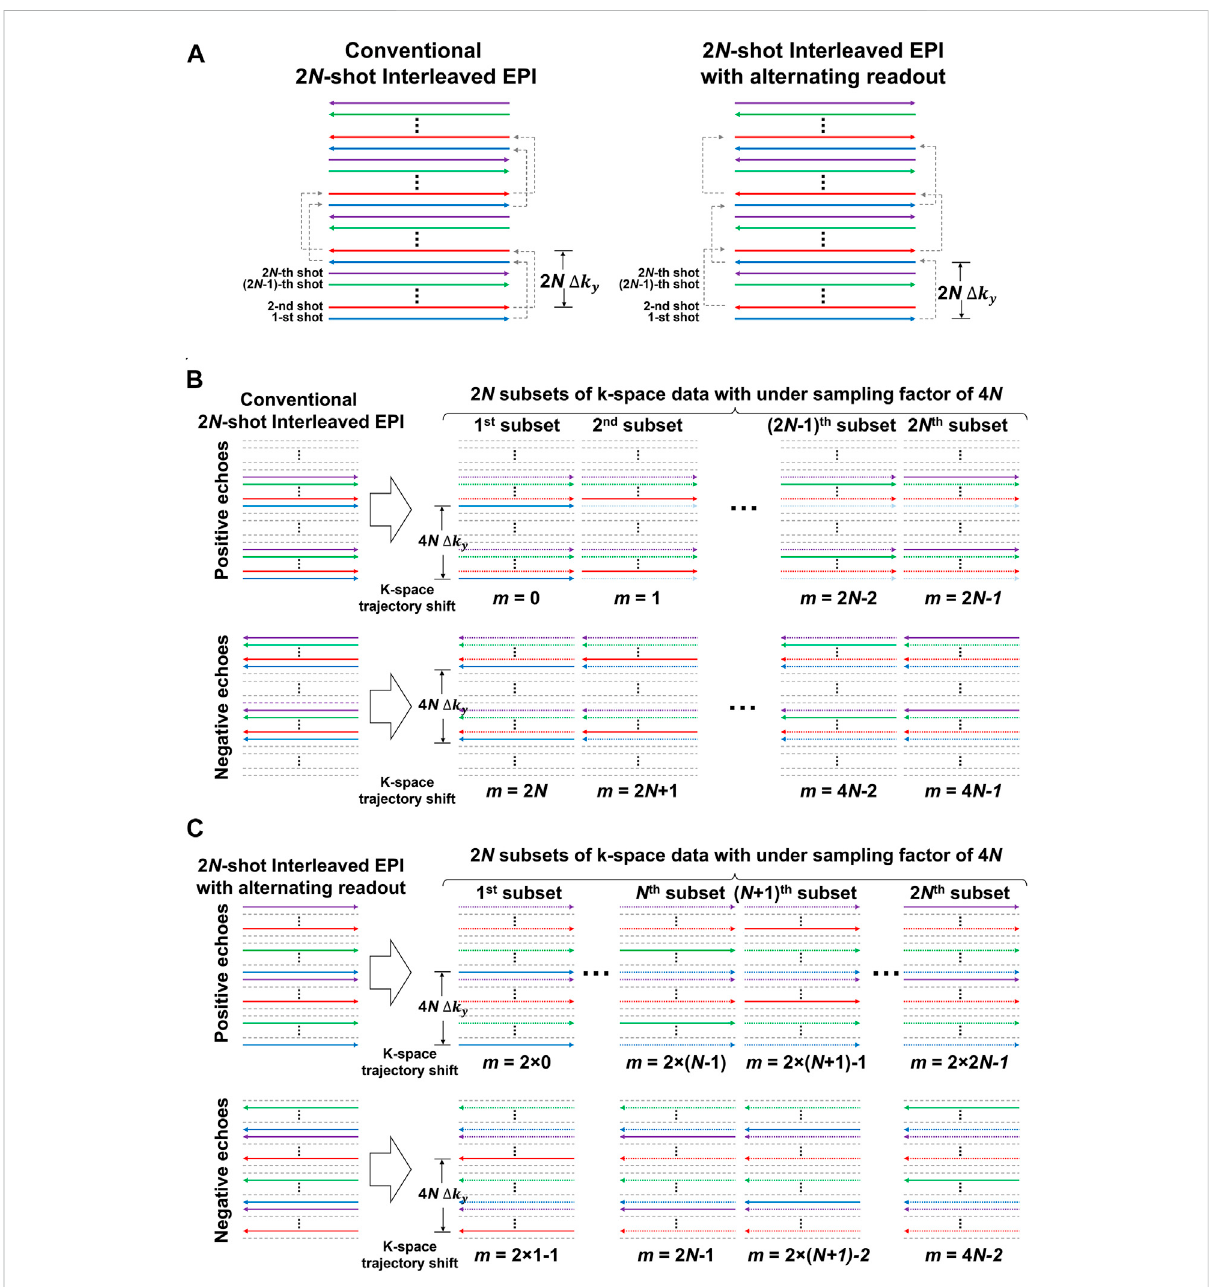
FIGURE 2 (A) The k-space trajectories of conventional multi-shot interleaved EPI (left) and multi-shot interleaved EPI with alternating readout (right). (B) k-spacedataof2 N -shotinterleavedEPIcanbeseparatedintotwodatasetsacquiredwitheitherpositiveornegativeechoesaccordingtothereadout polarity. Each separate dataset can be further split into 2 N subsets of k-space data with same under-sampling factor ( R ) as 4 N , and then reconstructedtoafully-sampledimageformeasuring2DphaseerrorofNyquistghost.However,whenthenumberofinterleavesincreases,the reconstruction of under-sampled data may fail for the separate dataset containing either positive or negative echoes. It is because N consecutive k-lines are missing for every N k-line in the separate dataset that can lead to lack of image energy around k-space center. (C) Alternating readout polarity during the acquisition of interleaves is adopted to achieve a nearly uniform sampling of k-space between positive and negative echoes, thereby improving the conditioning when reconstructing under-sampled data. For (A – C) , the trajectories with the same color represent the data acquired from the same